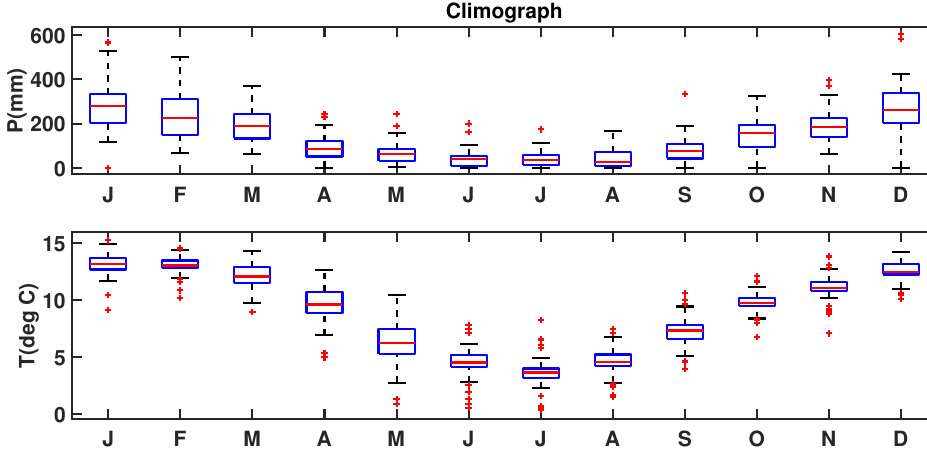
Figure 5. Climograph of Campos do Jordão city. ( Top ): Precipitation. ( Bottom ): Temperature. Intercorrelation of climate variables (P with T), with 95% confidence interval